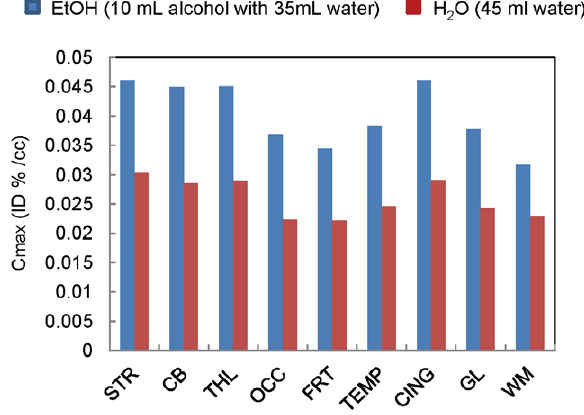
Figure 5. Brain uptake (C max ) of tracer 1 in baboon (Missy) in different brain region. STR: Striatum; CB: Cerebellum; THL: Thalamus; OCC: Occipital cortex; FRT: Frontal cortex; TEMP: Temporal cortex; CING: Cingulate gyrus; GL: Global; WM: White matter. When baboon was pretreated with water (45 ml) or alcohol (22% ABV, 45 ml).